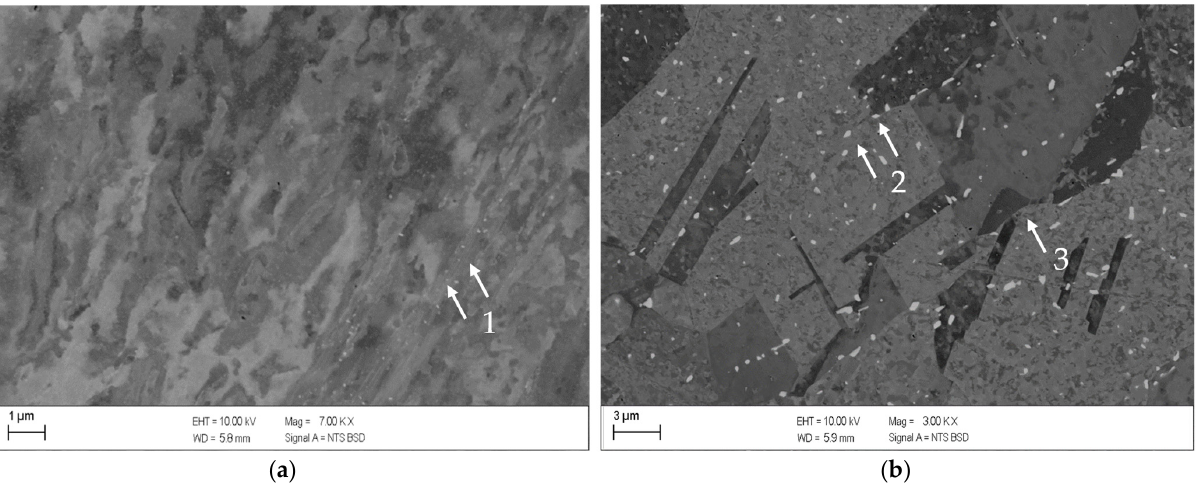
( b ) Figure 12. Precipitates of CuHf0.7 in their evolution during DSC measurements: specimen without cold rolling; ( a ) condition 1; ( b ) condition 2; showing the undissolved hafnium phase after casting (1), homogenously distributed lamellar hafnium enrichments of precipitates within a grain (2), fewer and smaller structures in the surroundings of the grain boundary (3) with hafnium migration in the intergranular space (4), and coarse precipitates due to further heating (5). Figure 13 shows microstructural changes, including precipitation and recrystalliza- tion for a specimen with 75% cross-section reduction due to cold rolling. The investigation of condition 1 shows how precipitates grew preferentially at crystallographic defects, such as dislocations, which is why they are clearly visible along the slip bands in Figure 13a (magnification 7000). Therefore, the effect at 491.1 °C can be related to the precipitation process. Heating up to 800 °C showed its results in Figure 13b (magnification 3000) with